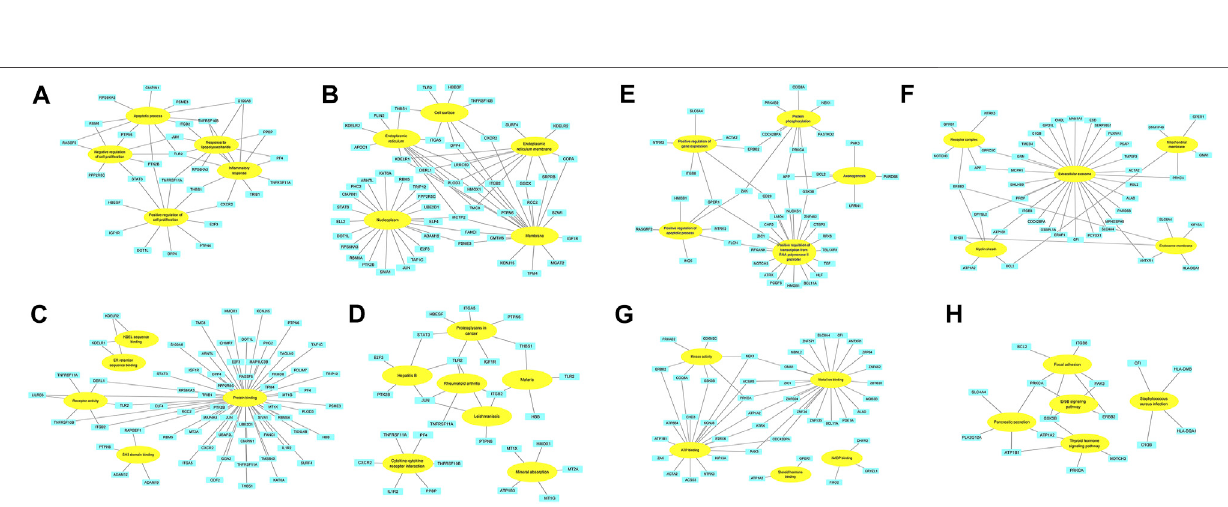
Frontiers in Genetics |